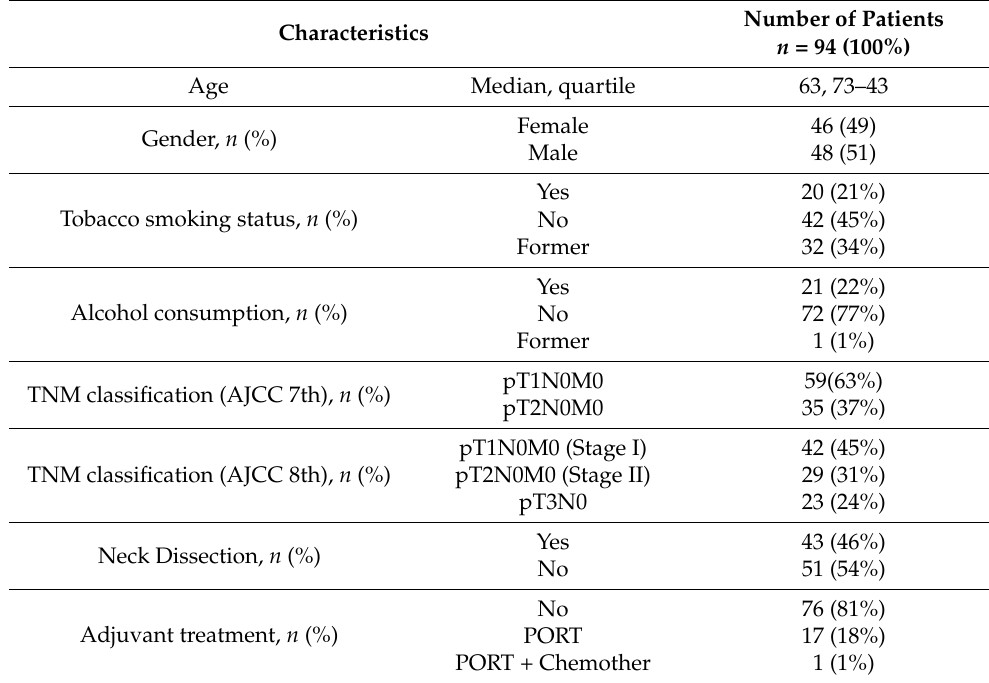
Table 1. Tumor and treatment characteristics.